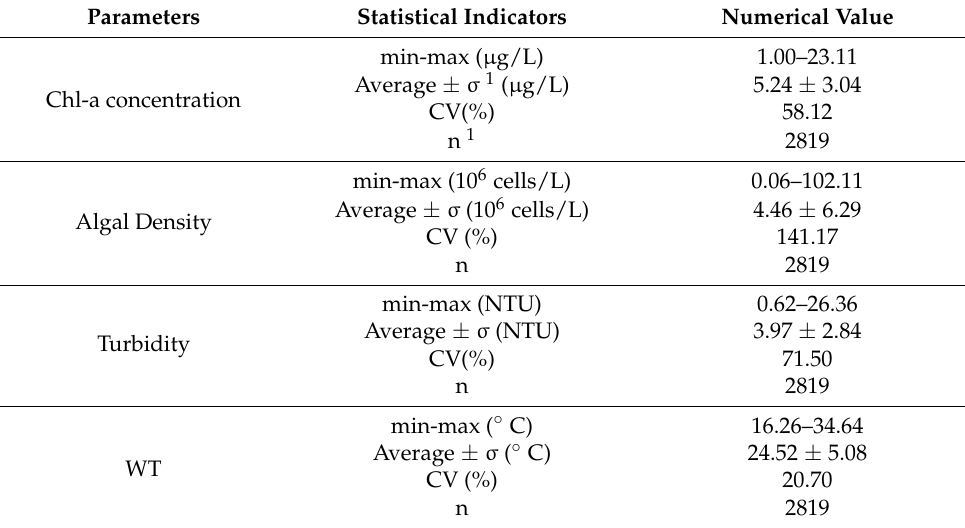
Table 5. Descriptive statistics from Shanmei